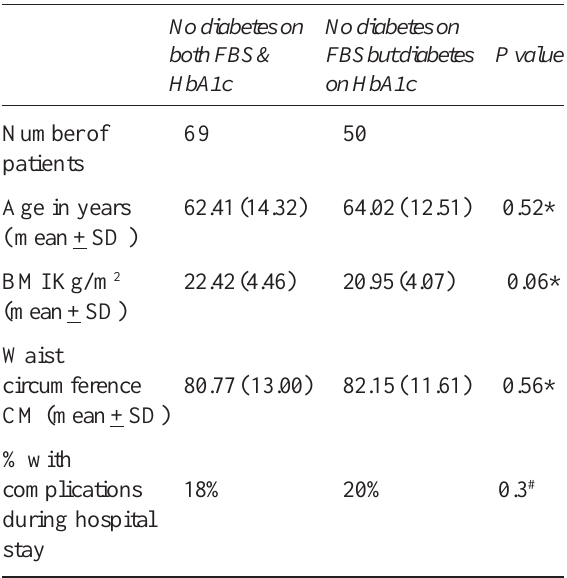
Table 3. Comparison of patients with no diabetes by both tests vs diabetes on HbA1c with no diabetes by